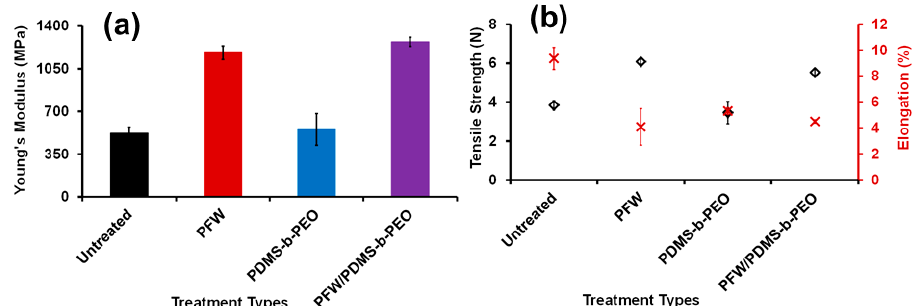
Figure 5. Young’s modulus ( a ), and tensile strength, and elongation percentage ( b ) of untreated, PFW, PDMS- b -PEO and PFW/PDMS- b -PEO -treated FP samples.